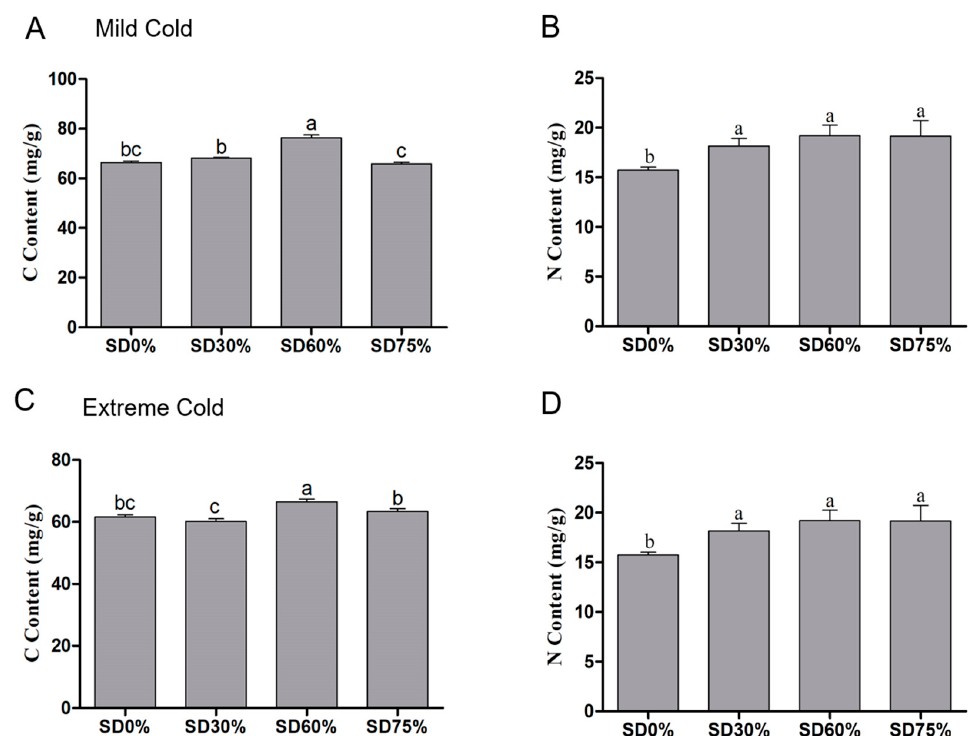
Figure 7. Effects of shading nets on ( A ) carbon content and ( B ) nitrogen content, during mild cold condition, and ( C ) carbon content and ( D ) nitrogen content during extreme cold conditions. Different letters on the top of the columns within each figure represent significant differences between the treatments indicated by LSD test at p < 0.05.